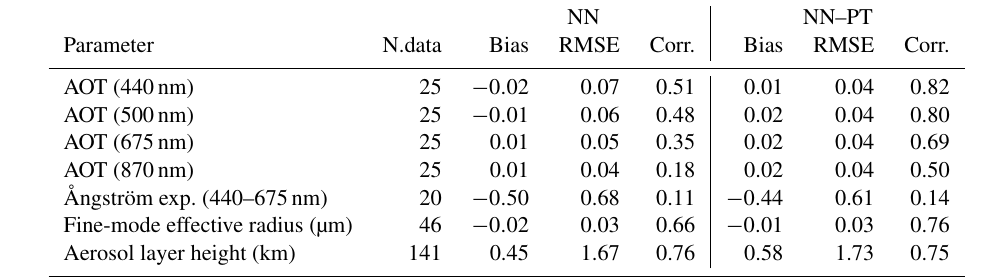
Table 6. Error statistics from the comparisons shown from Figs. 12 to 15. for the neural network (NN) and for the Phillips–Tikhonov retrieval initialized using the neural network (NN–PT). N. data is the number of data points from which the reported statistics are computed. NN